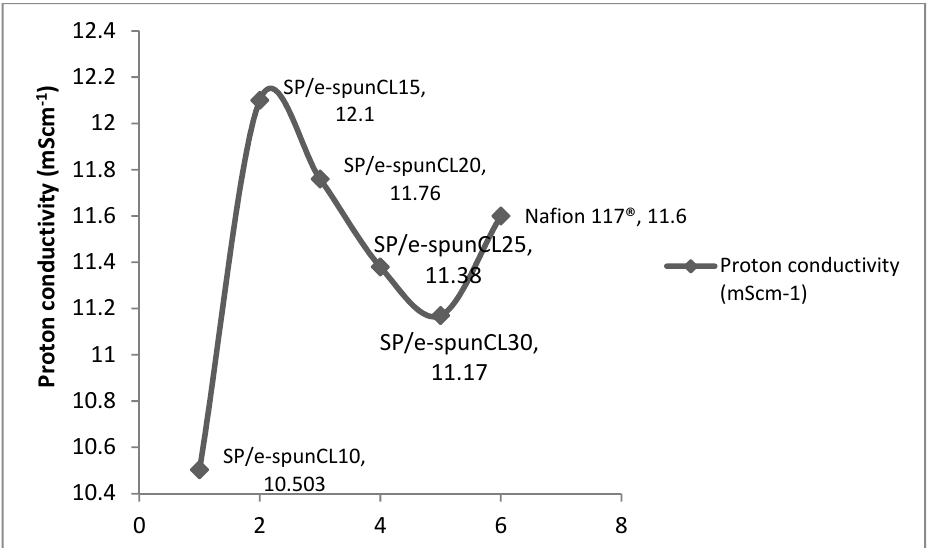
Figure 5. Proton conductivity of Nafion117 ® and all membrane samples at room temperature.